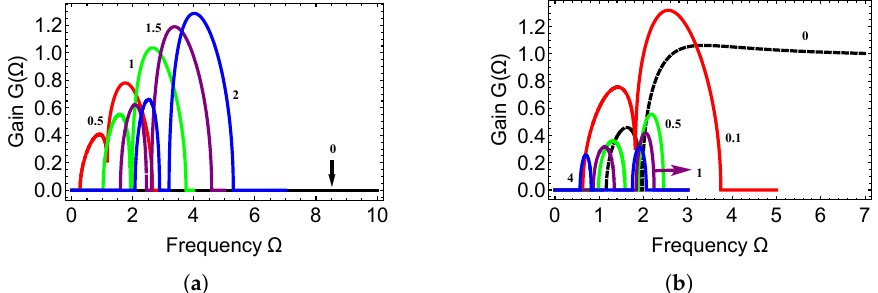
Figure 6. ( a ) The MI gain spectra in the normal-GVD regime ( σ 1 = − 1) for different values of ( a ) the coupling coefficient, κ , indicated near the curves. Other parameters are P = 1, η = 0.5, α = 0.1, Γ = 2 and ρ = 0.01. ( b ) The change of values of the difference in normal-GVD coefficients ( σ 1 = − 1), α , in the two cores of the nonlinear coupler (the values of α are indicated near the curves). Other parameters are P = 1.5, η = 0.5, κ = Γ = 1 and ρ = 0.1.